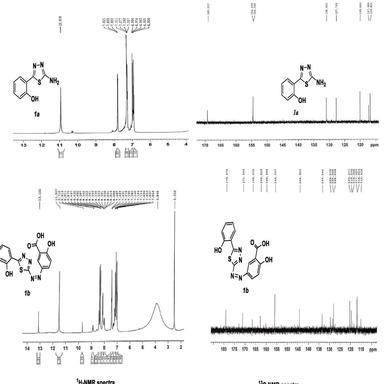
1 H NMR spectra and 13C NMR spectra of 2-(5-amino-1,3,4-thiadiazol-2-yl)phenol (1a) and 2-hydroxy-5-((5-(2-hydroxyphenyl)-1,3,4-thiadiazol-2-yl)diazenyl)benzoic acid (1b).